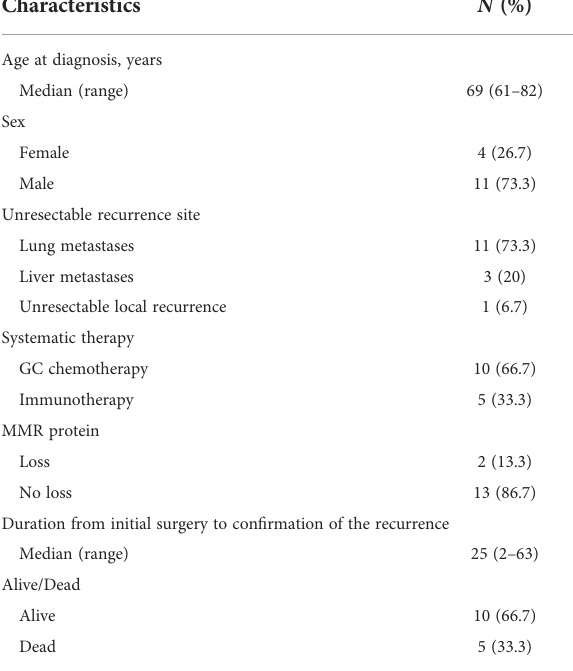
TABLE 4 Characteristics of patients developing distant or unresectable locoregional recurrence during the follow ‐ up period ( N = 15).